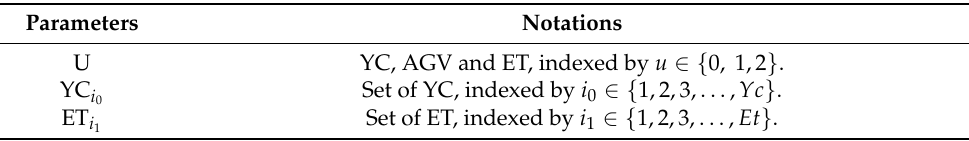
Table 1. Parameter